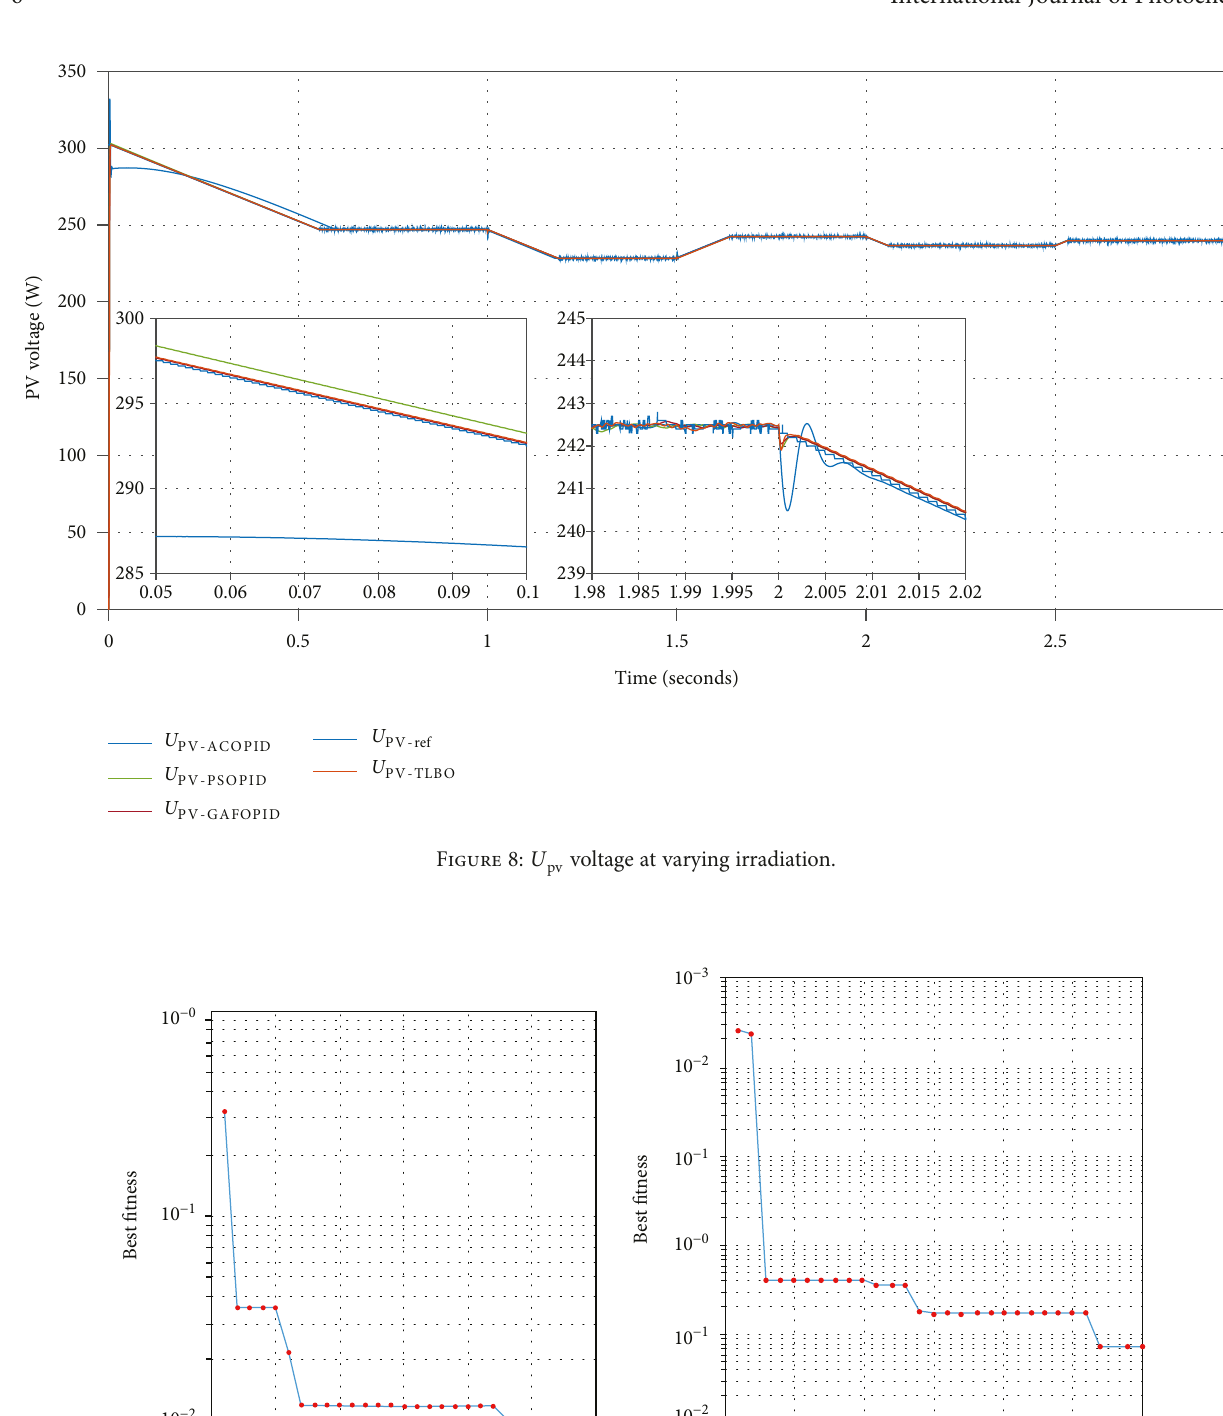
dq (a) and the outer loop U dc